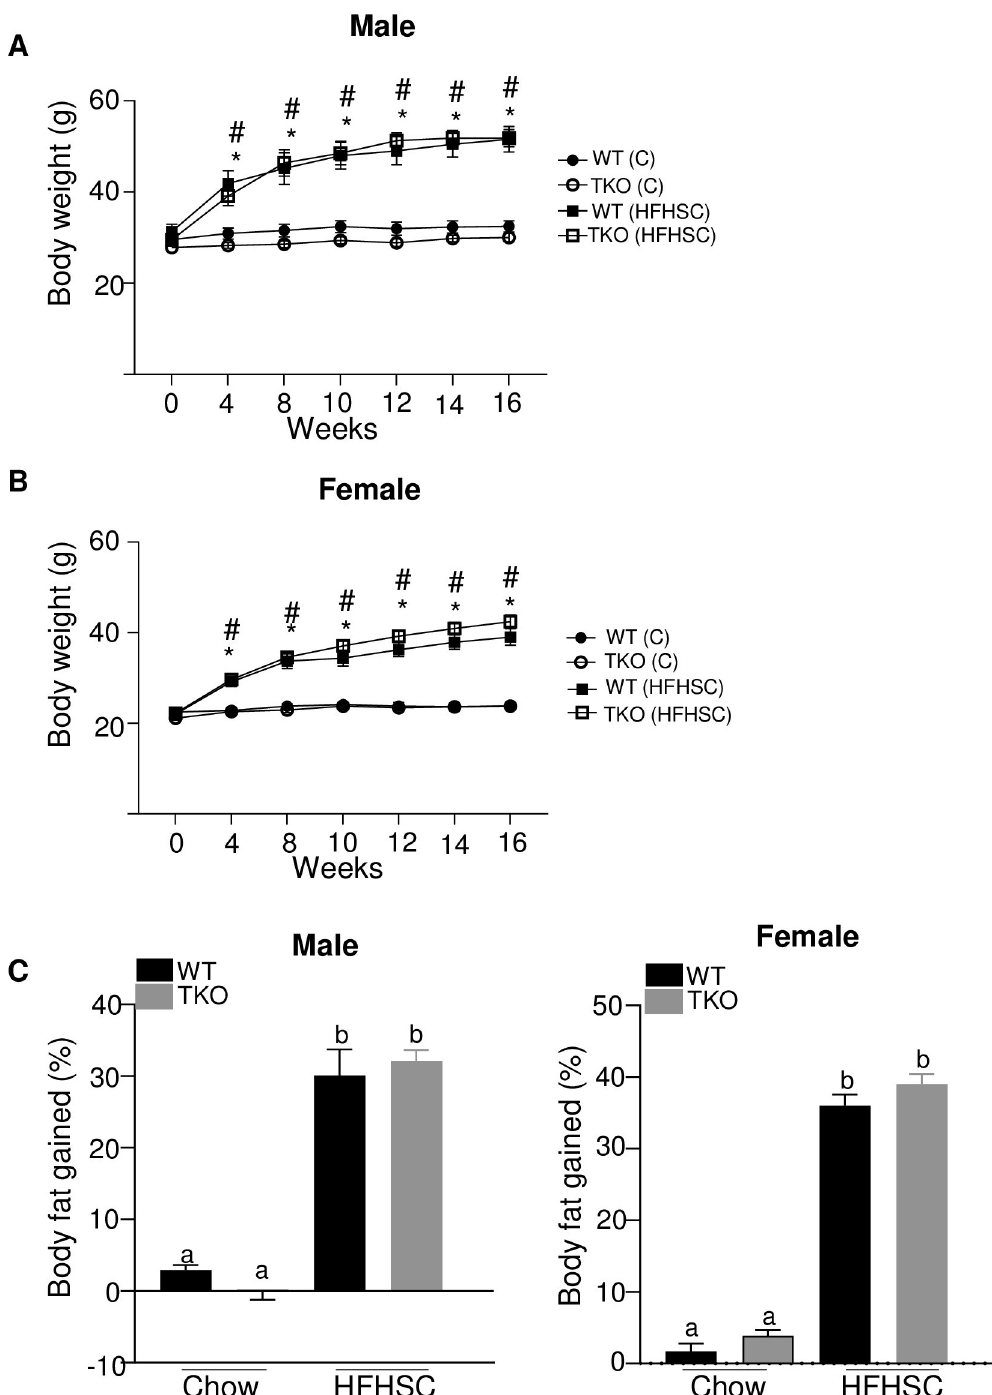
Fig 3. Deficiency of SAA does not affect the development of diet-induced obesity. A) body weight changes in male mice during the course of diet feeding B) body weight changes in female mice during the course of diet feeding C) percentage body fat gained in 15 weeks of chow and HFHSC diet feeding in male (left panel) and female mice (right panel). n = 5–15 mice/ group; Data are mean ± SEM; A and B: � and # = P � 0.05 between WT (C) and WT (HFHSC) and between TKO (C) and TKO (HFHSC) respectively. In C, groups that are not significantly different (p � 0.05) are indicated with the same letter.